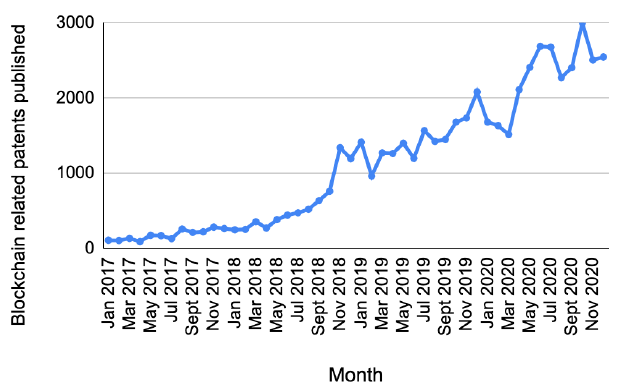
Figure 7: Blockchain-related patents published per